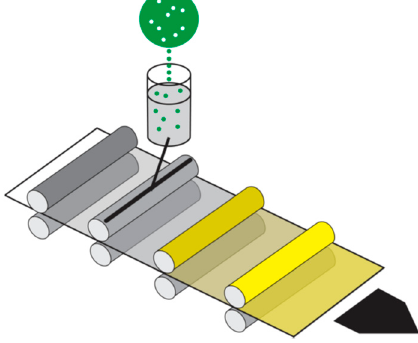
Figure 1. Micro LED lighting manufacturing